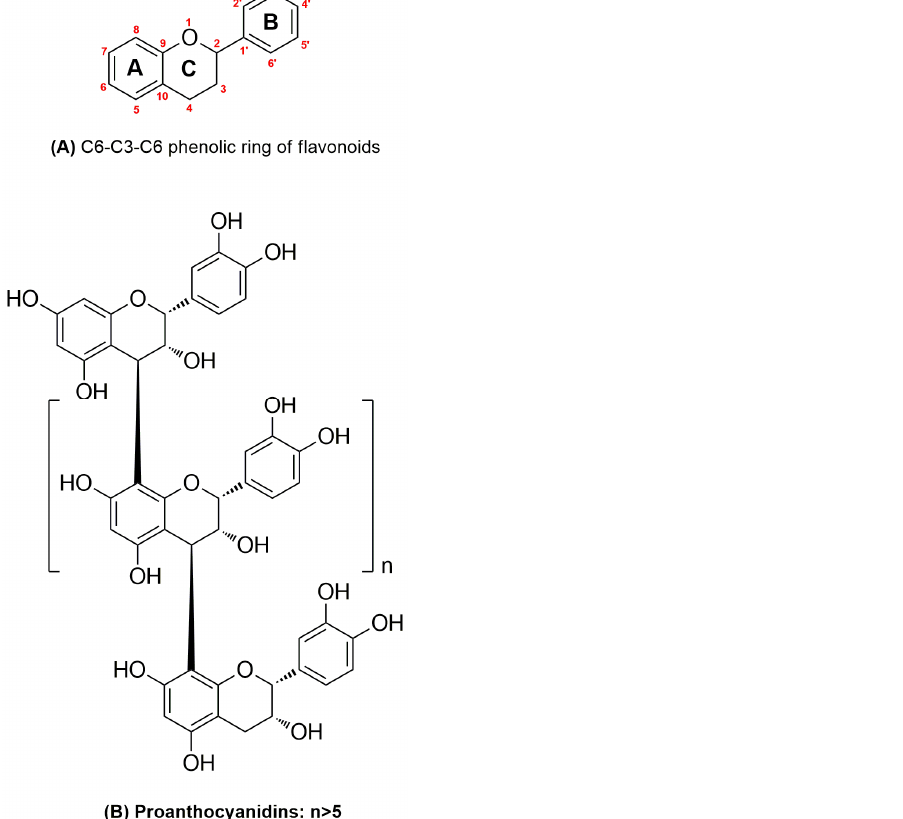
Figure 1. Chemical Structures of ( A ) C6–C3–C6 phenolic ring of flavonoids, ( B ) Polymeric PAs connected through C4 → C8 linkage.